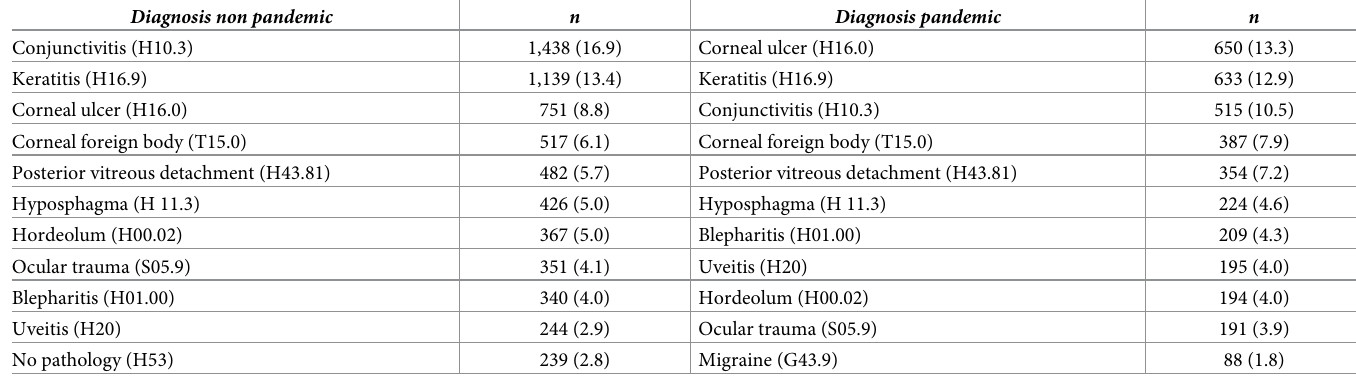
Table 5. Leading diagnoses and their International Statistical Classification of Diseases and Related Health Problems, Tenth Revision (ICD-10) codes in six repre- sentative months after the COVID-19 pandemic outbreak (September 2020–February 2021) compared with the same period of the year before. Diagnosis non pandemic n Diagnosis pandemic n Conjunctivitis (H10.3)